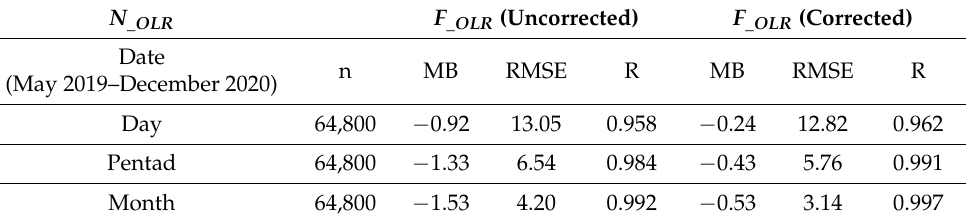
Table 1. Comparison of the bias statistics values for the Fengyun-3D outgoing longwave radiation (OLR) data ( F _OLR ), the corrected F _OLR , and the NOAA OLR data ( N _OLR ). MB indicates the mean bias, RMSE indicates the root mean square error, R indicates the correlation coefficient, and n indicates the total number of data points.